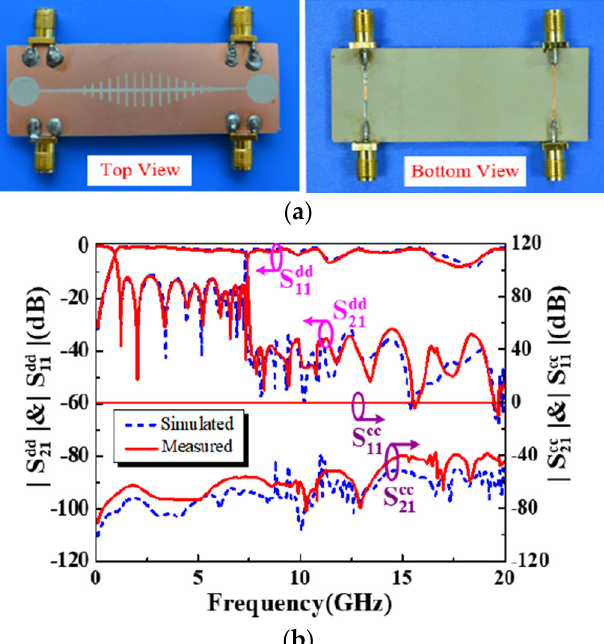
Figure 19. The proposed wide-band balanced BPF [89]: ( a ) Photograph for the prototype; ( b ) S- parameter performances.